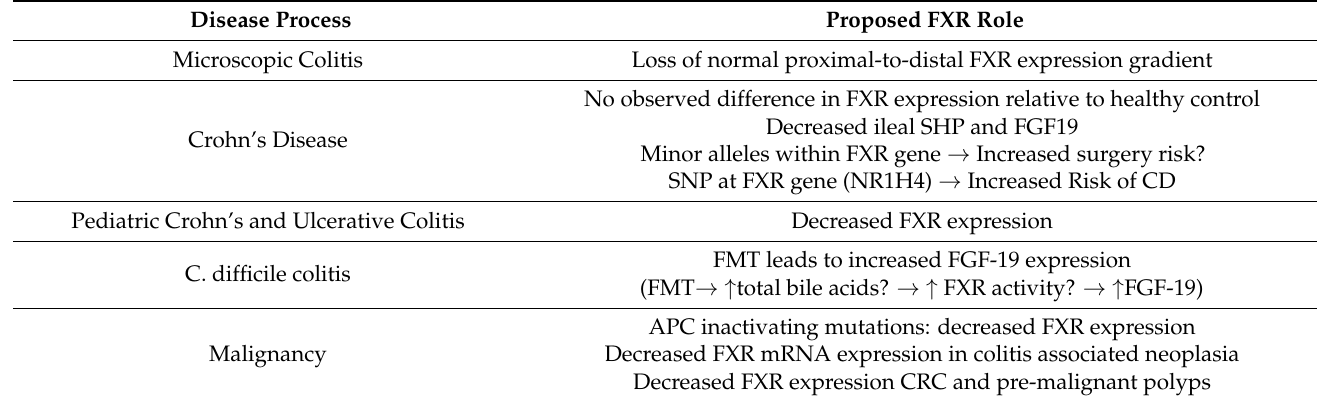
Table 2. Described roles of FXR in known clinical diseases of the intestine (CD—Crohn’s disease, FMT—fecal microbiota